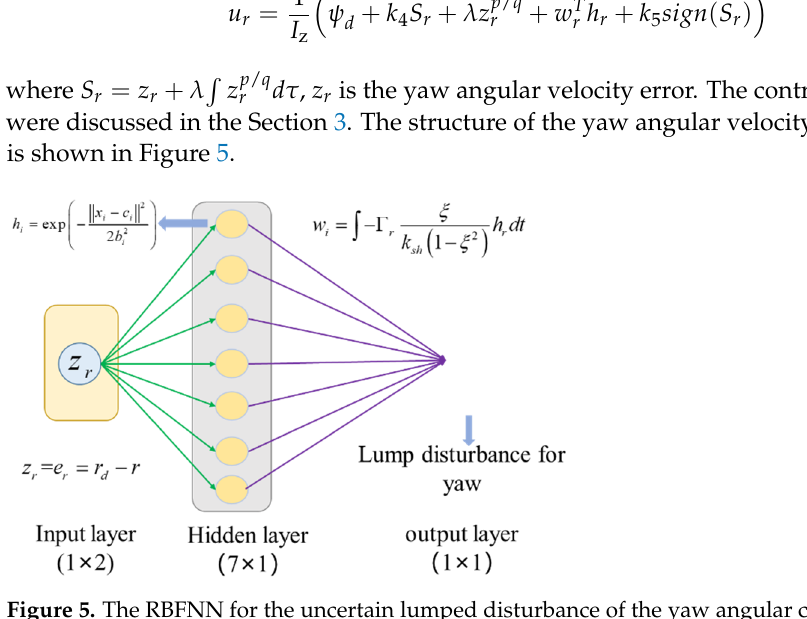
Figure 5. The RBFNN for the uncertain lumped disturbance of the yaw angular controller. The input layer of the RBFNN only has the yaw angular velocity error, and the output of the neural network is the lump disturbance. The hidden layer includes seven neurons. The center vector matrix of the Gaussian function of neurons is (cid:2) − C = 0.4 −